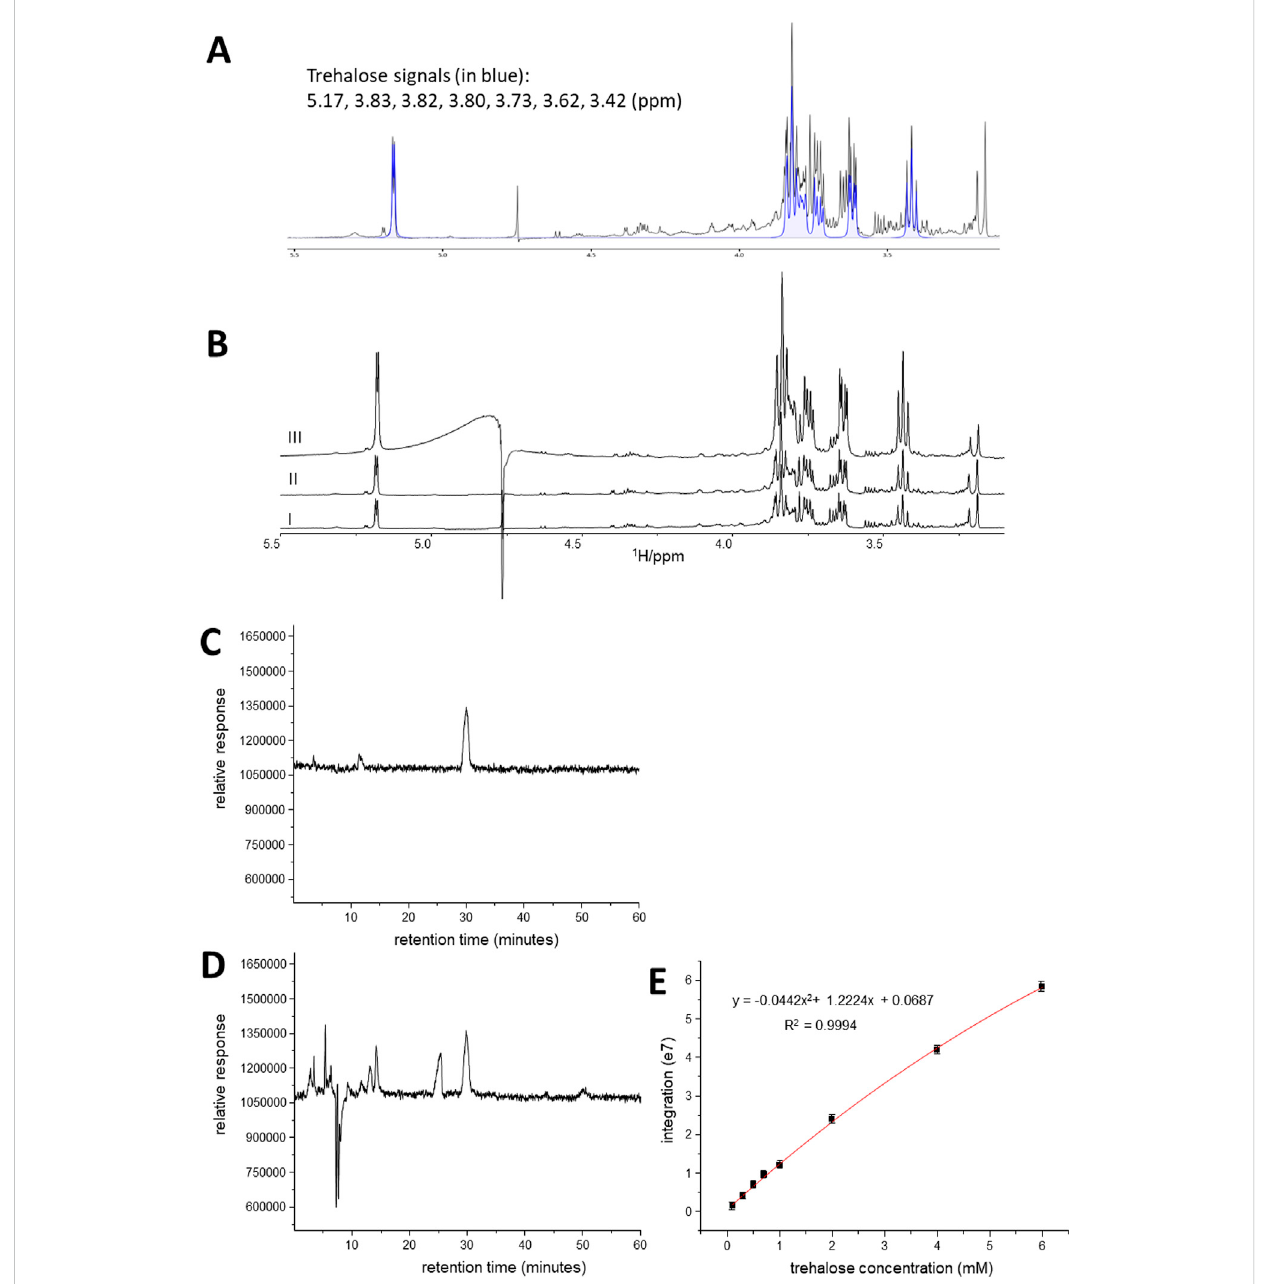
FIGURE 9 Analysis of AME-1 by NMR and HPLC. (A) Expanded region of 1 H NMR of AME-1 highlighting the signals of trehalose (in blue color). (B) 1 H NMR of AME-1 before (I) and after trehalose spiking (II: with 0.7 mM trehalose; III: with 4 mM trehalose). The intensity of signals centered at 5.17, 3.83, 3.80, 3.73, 3.62, and 3.42 ppm was increased when trehalose was added. (C – E) HPLC-MS chromatograms of trehalose standard (C) and 100X dilute AME-1 (D) showing the separation of trehalose from other metabolites. The mass spectrometer was operated in scan mode (C, D) . (E) Trehalose calibration curve. Standards containing varying concentrations of trehalose were injected onto the LC-MS with SIM mode. Data presented as mean ± SD for n =